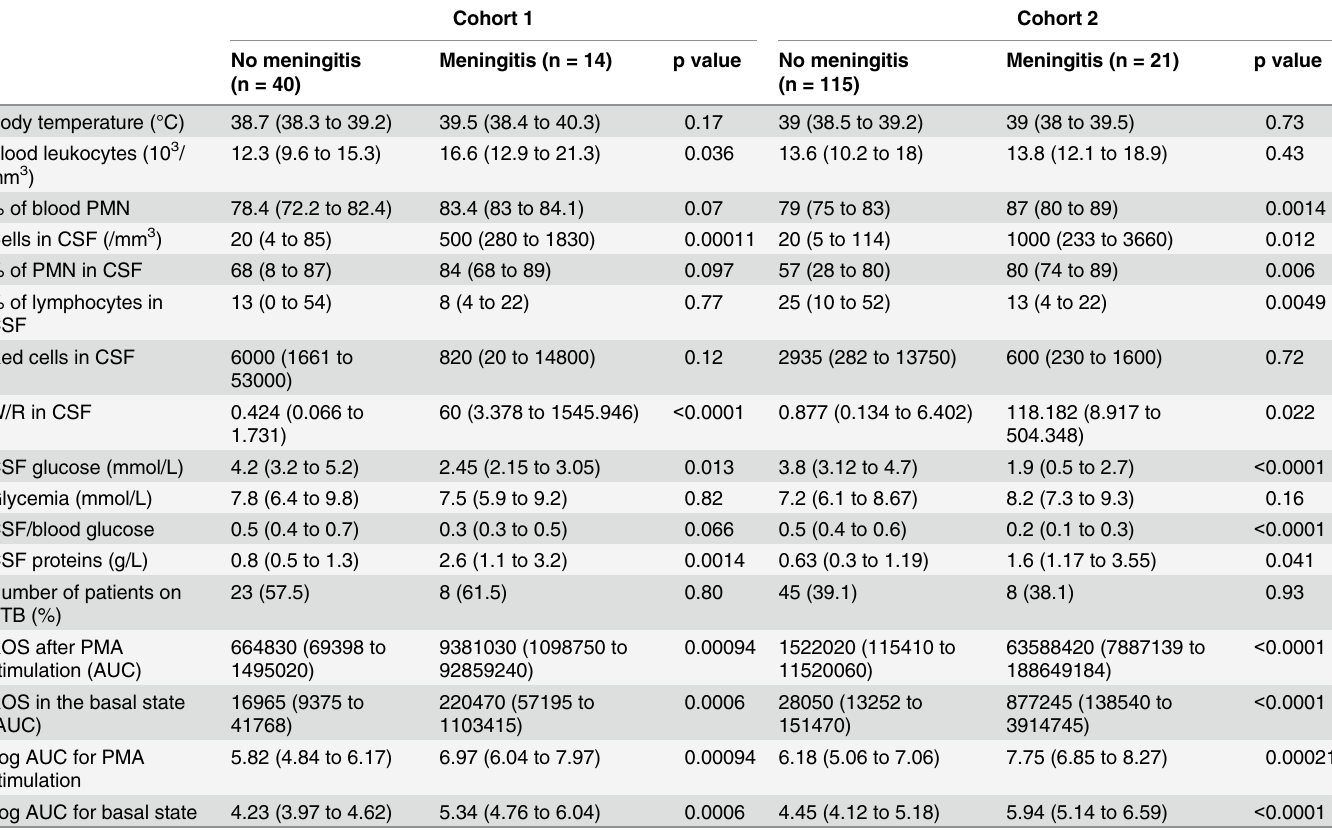
Table 2. Clinical and biological characteristics in cohorts according to the diagnosis of